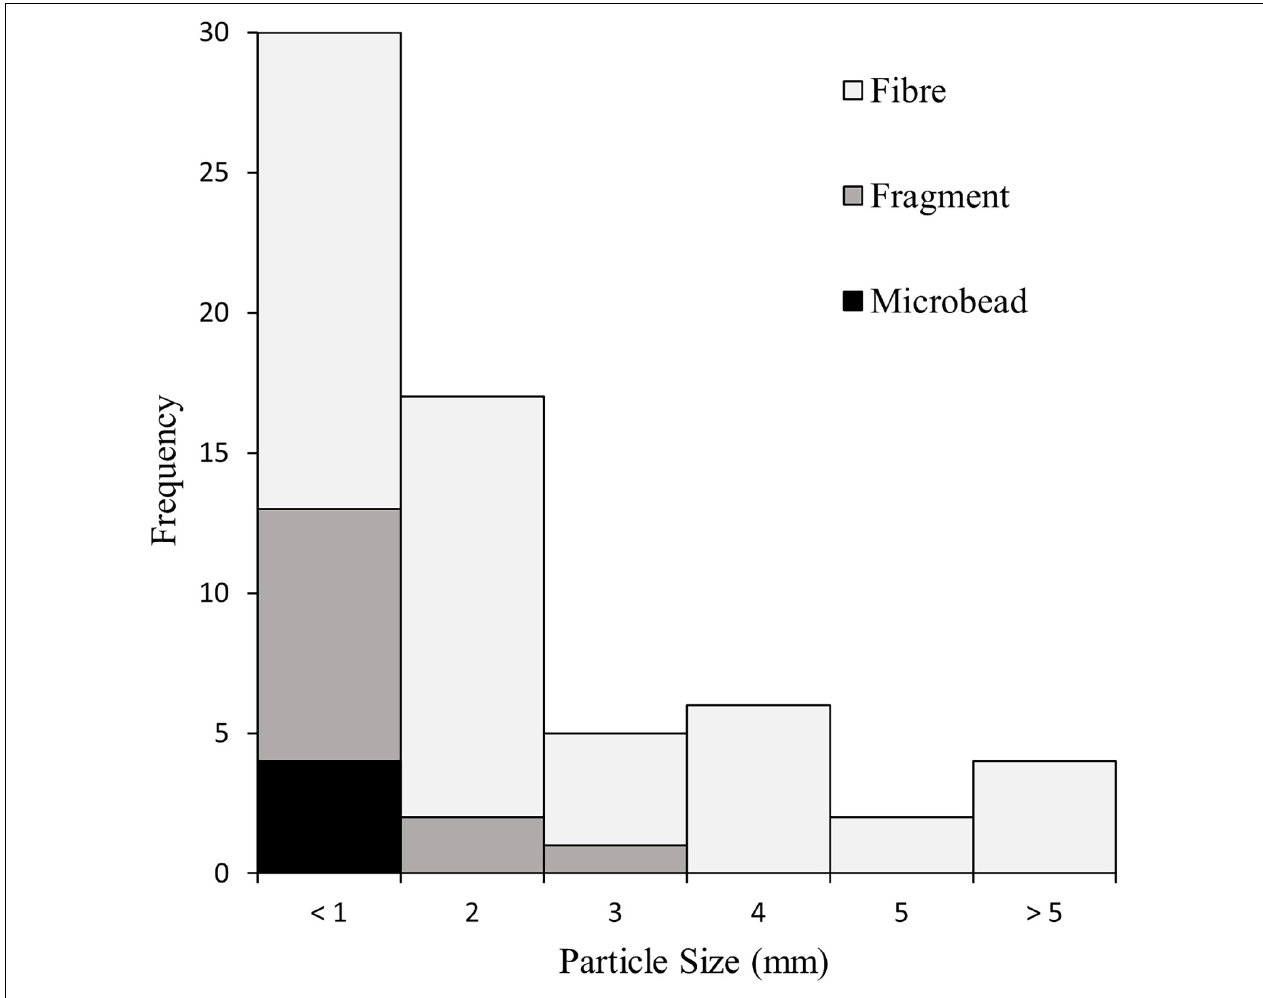
FIGURE 4 | The size distribution of subset particles recovered from the gastrointestinal tracts of sardines caught in Frenchman Bay, Western Australia in January